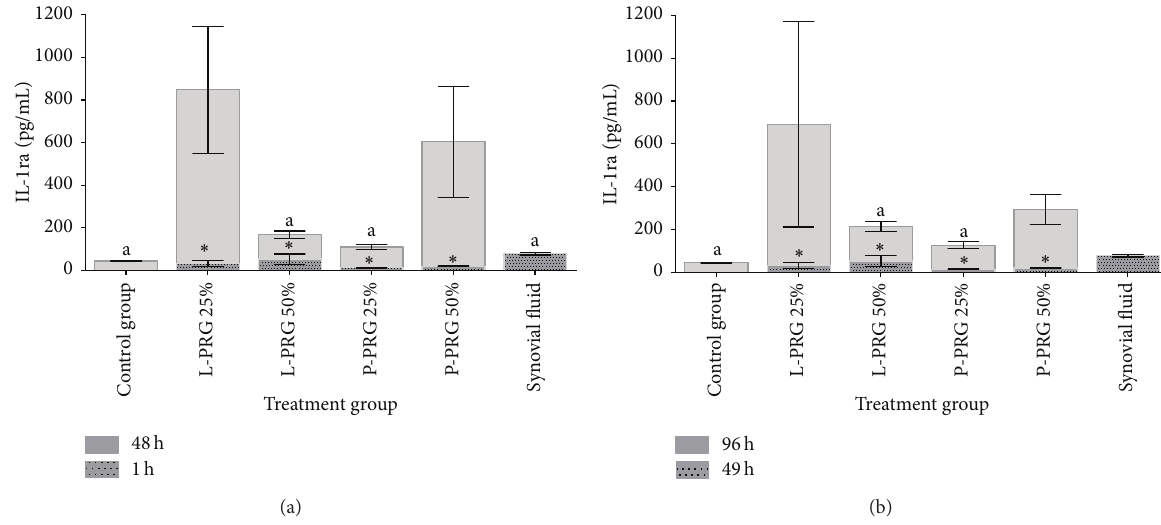
Figure 5: (a) a-b Lowercase letters denote significant ( 𝑃 < 0.05 ) differences between groups in the same column by Tukey test at 48 h. Significantly different with a: L-PRG 25%. (b) a Lowercase letters denote significant ( 𝑃 < 0.05 ) differences between groups in the same column by Tukey test at 96 h. Significantly different with a: L-PRP 25%. ∗ Significant differences ( 𝑃 < 0.05 ) between the same variable at 1h and 48 h and at 49 h and 96 by 𝑡 -paired